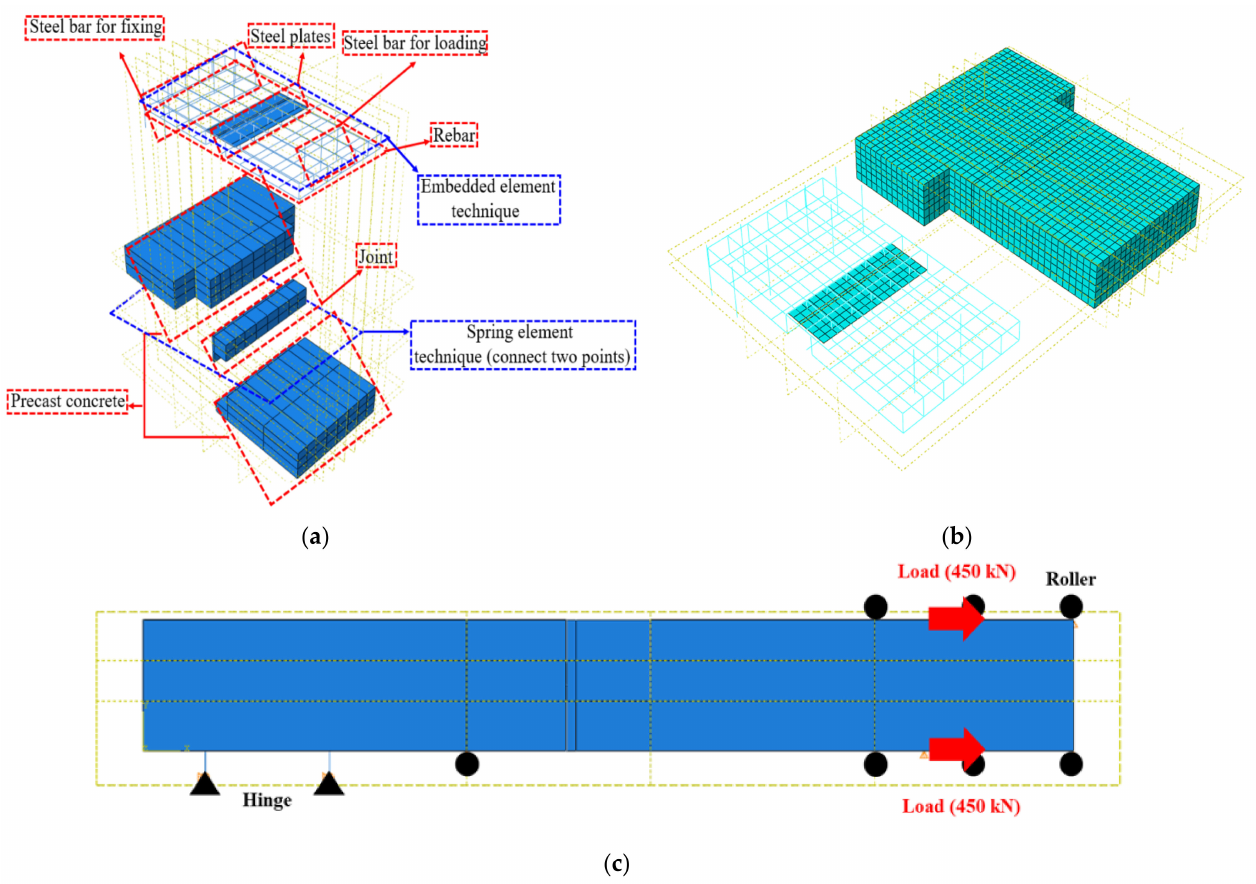
Figure 12. Mesh and conditions for FEM of J100-HB-SP. ( a ) View of model components. ( b ) Model mesh. ( c ) Load and boundary